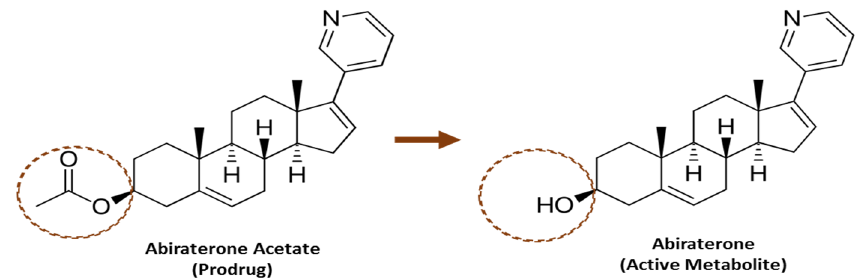
Figure 1. Structure of Abiraterone Acetate and Abiraterone.